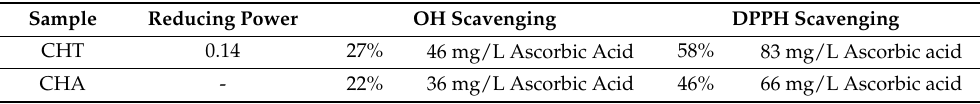
Table 7. Resume of antioxidant activity properties of CHT and CHA.